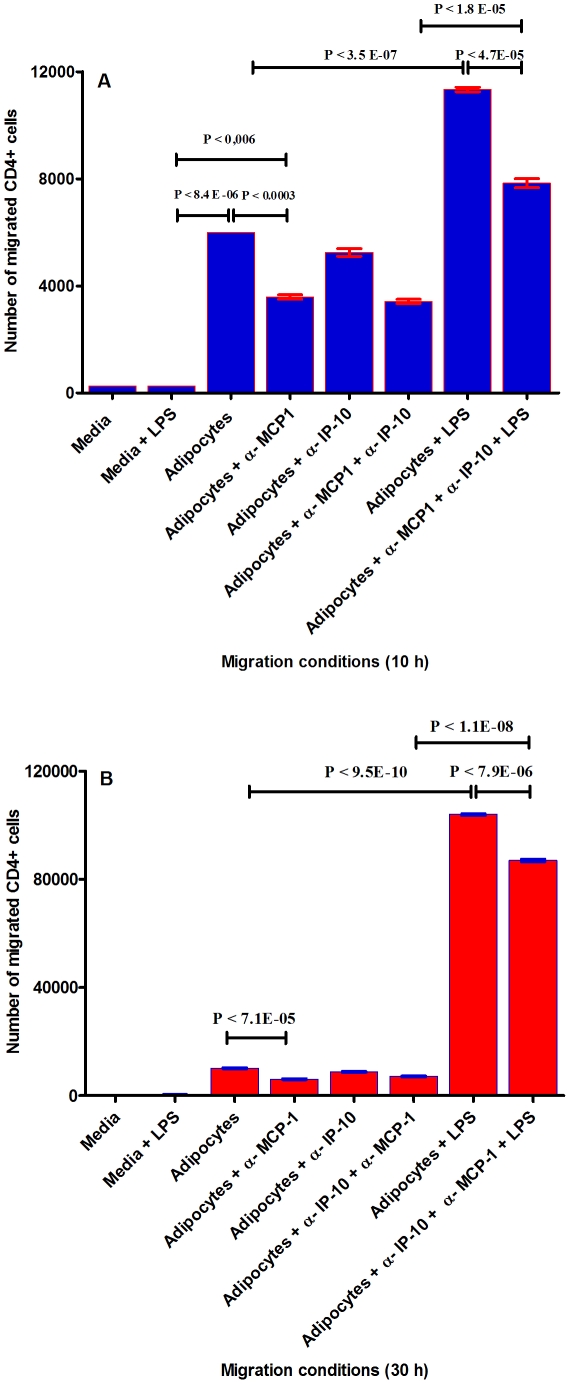
The activation of CD4+ cells by human adipocytes.
Panel A shows the analysis of CD4+ cells migration caused by adipocytes-produced chemokines after 10 h incubation. The lower compartment (insert) contained attached adipocytes treated with LPS (200 ng/ml) or untreated, as well as antibodies against MCP-1 and IP-10 (2 µg/ml) to neutralize the effect of these two chemo-attractants. The upper chamber (insert) contained purified and rested CD4+ T cells. The cells were incubated at 37°C for 10 h. The inserts were then removed and the cells migrated toward the adipocytes were collected in culture medium without serum. The number of migrated cells was obtained by cell counting using a Bürker-Türk chamber. This figure represents two independent experiments with similar results (only differ in the number of migrated cells). Each experiment was done in triplicate. Error bars show standard deviations of means for triplicate cultures per condition. The p-value obtained from an independent two-tailed test samples (T-test). P<0.05 was accepted as statistically significant. The controls in the migration assay were 1- culture medium without serum, 2- culture medium serum free with LPS, and culture medium serum free with IgG isotype (this is not shown in Figure 10
A and 10 B, because this was executed separately and the obtained results were the same as culture medium serum free with LPS). Panel B shows the analysis of CD4+ cells migration caused by adipocyte-produced chemokines after 30 h incubation. All cell migration conditions were similar to the conditions described in panel A, except that the cells were incubated at 37°C for 30 h.